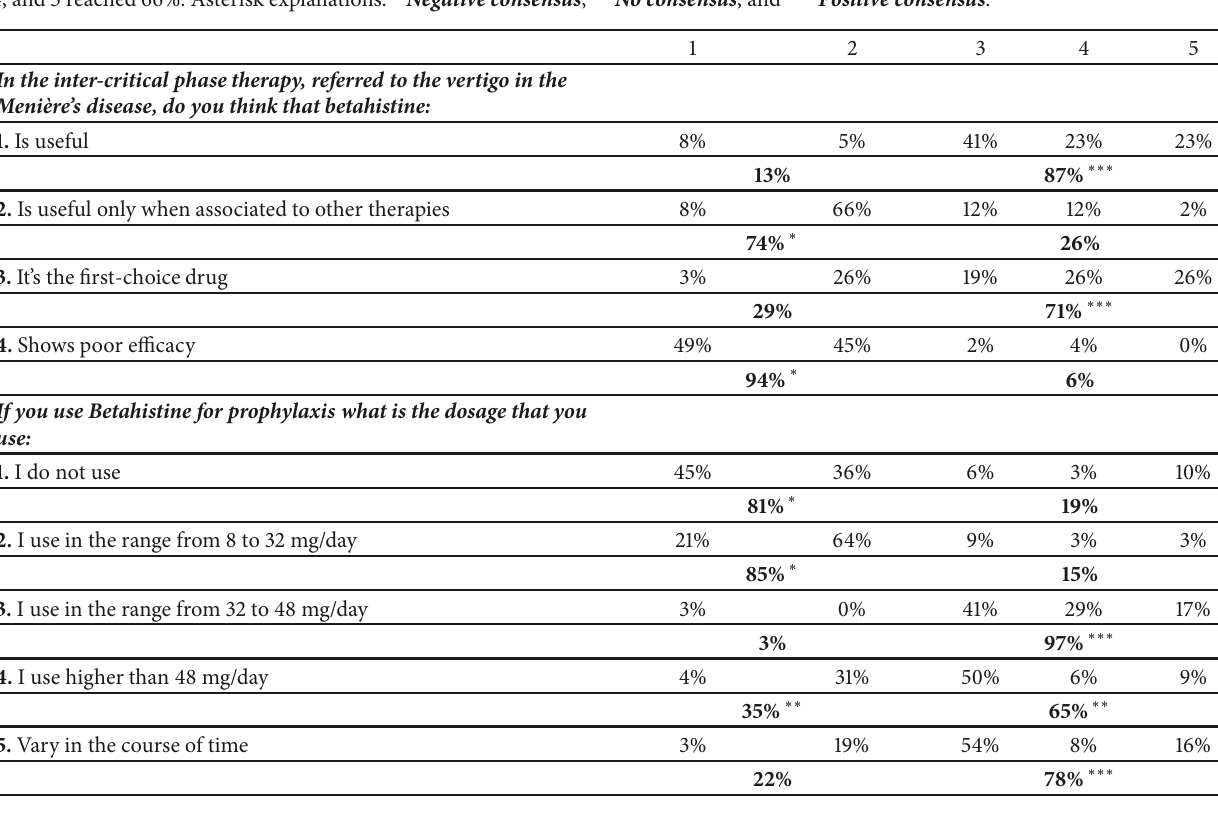
Figure 1: Process used to select and achieve consensus for statements about betahistine in Meni`ere’s Disease. Table 1: Results of the Consensus Conference on the use and dosage of betahistine during the intercritical phase of MD. 1 = absolutely disagree, 2 = disagree, 3 = agree, 4 = more than agree, and 5 = absolutely agree. Consensus was reached when the sum of items 1 and 2 or 3, 4, and 5 reached 66%. Asterisk explanations: ∗ Negative consensus , ∗∗ No consensus , and ∗∗∗ Positive consensus